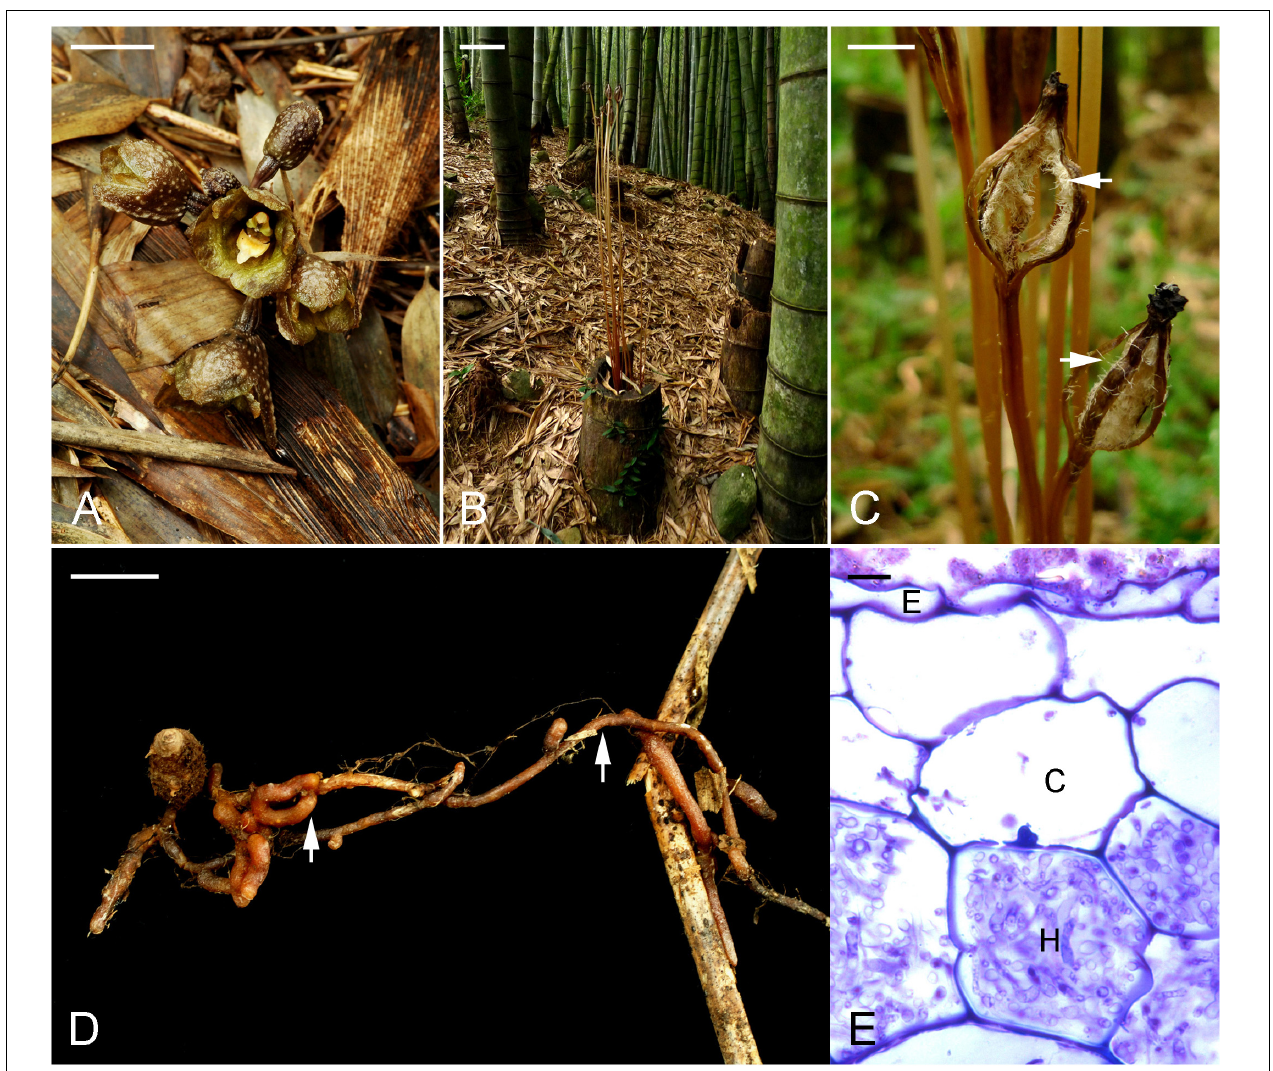
FIGURE 1 | Gastrodia confusoides in its natural habitat. (A) Adult plants with blooming flowers growing between bamboo litter. Scale bar = 1 cm. (B) Stem elongation after flowers have been successfully pollinated. Scale bar = 10 cm. (C) After 2 weeks of pollination, mature fruits have opened, and released seeds (arrows). Scale bar = 1 cm. (D) The tube with mycorrhizal roots (arrows) in decaying bamboo litter. Scale bar = 1 cm. (E) Light microscopy section showing the presence of mycorrhizal fungi in cortical cells of roots. E, epidermal cells; C, cortical cells; H, fungal hyphae. Scale bar = 10 µ